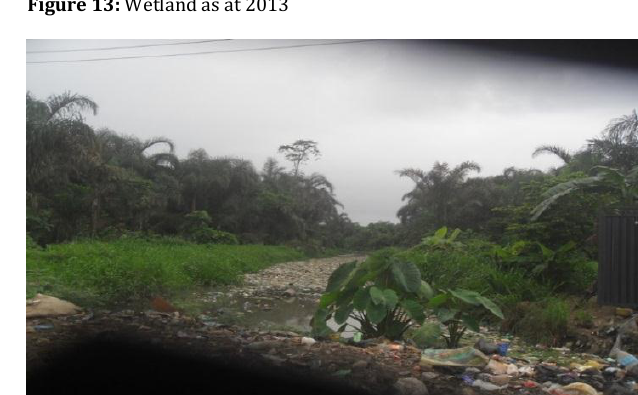
Figure 12: Wetland as at 2003 Figure 13: Wetland as at 2013